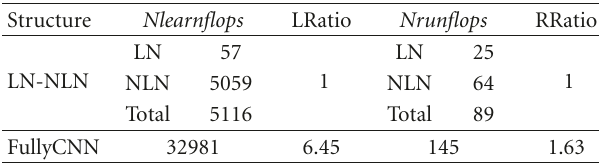
Table 2: Complexity comparison of predistorter structures.